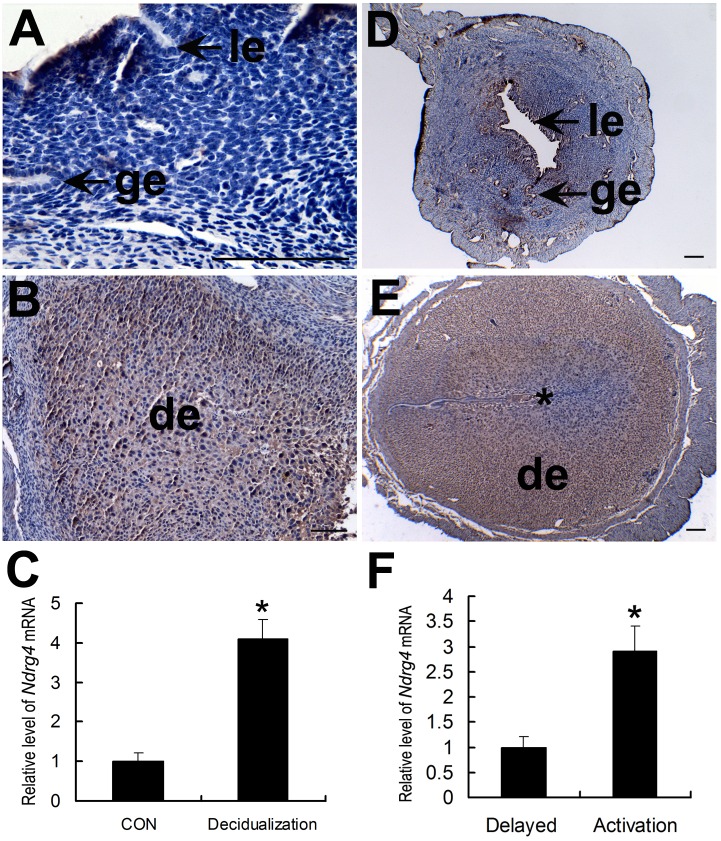
Uterine NDRG4 expression following artificial decidualization and activation of delayed implantation.Immunohistochemical analysis of uterine NDRG4 protein expression following artificial decidualization (B) and in its contralateral uninjected uterine horn (A), under delayed implantation (D) and activation (E). Quantitative PCR analysis of NDRG4 mRNA expression in the uterus following artificial decidualization (C) and activation of delayed implantation (F) (n = 3). The thick arrow indicates the luminal epithelium. The small arrow shows the glandular epithelium. De, decidua; *, significantly different from control (P < 0.05).